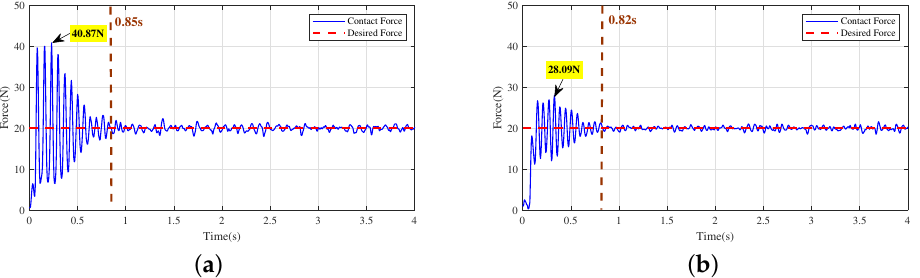
Figure 14. Contact force response when the tool of end-effector is 5 mm away from the workpiece surface (polishing spindle rotates): ( a ) Direct force control without impedance matching. ( b ) Direct force control with impedance